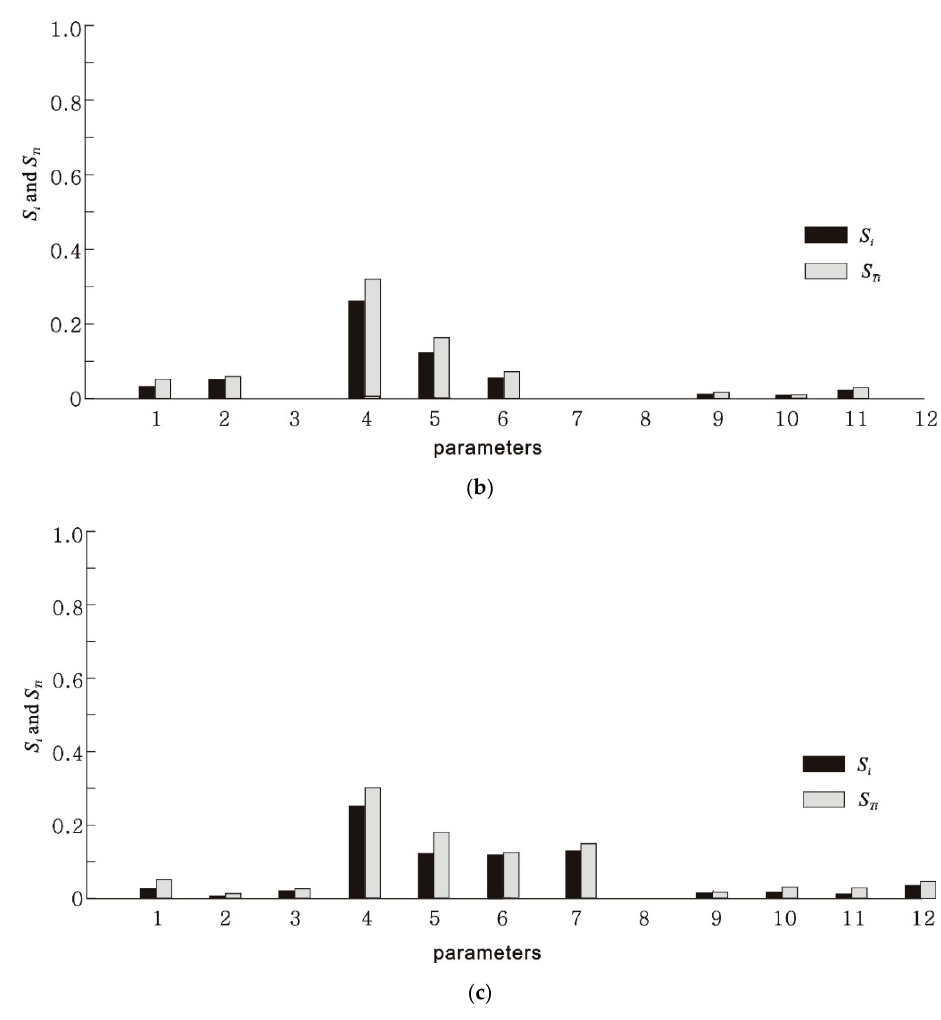
Figure 7. Comparison of the first- and total-orders of Sobol's sensitivity indices ( S i and S Ti ) of the parameters in the simulation of ( a ) flow rates, ( b ) NH 4+ -N concentration, and ( c ) NO 3 − -N